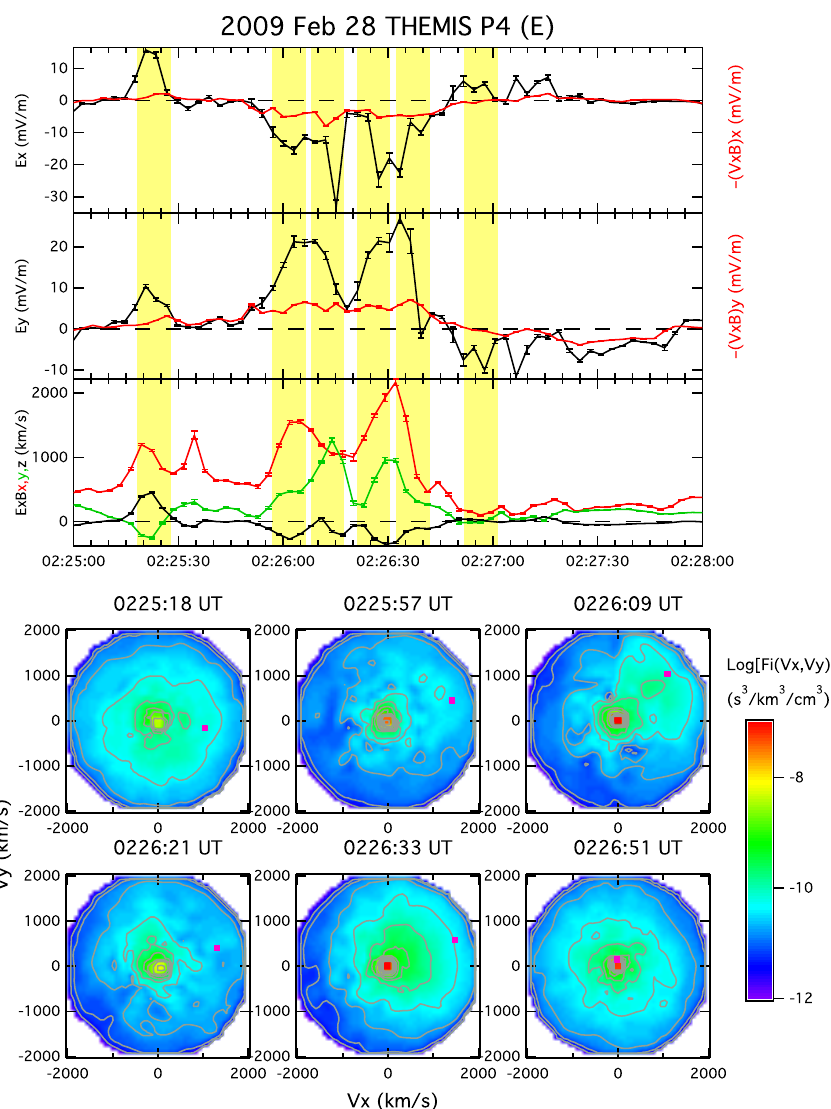
Fig. 4. Comparison between observed electric field components E x and E y and the values expected from the frozen-in condition of E = − V × B . The third panel shows the expected plasma flow components from the frozen-in condition. Error bars shown in the top three panels denote the standard errors of the mean. The bottom two rows show a sequence of the ion velocity distributions in the perpendicular flow components V x and V y for comparison to indicate the observed velocity distributions do not match the required velocity shifts (denoted by the red dot) needed to match the E × B plasma